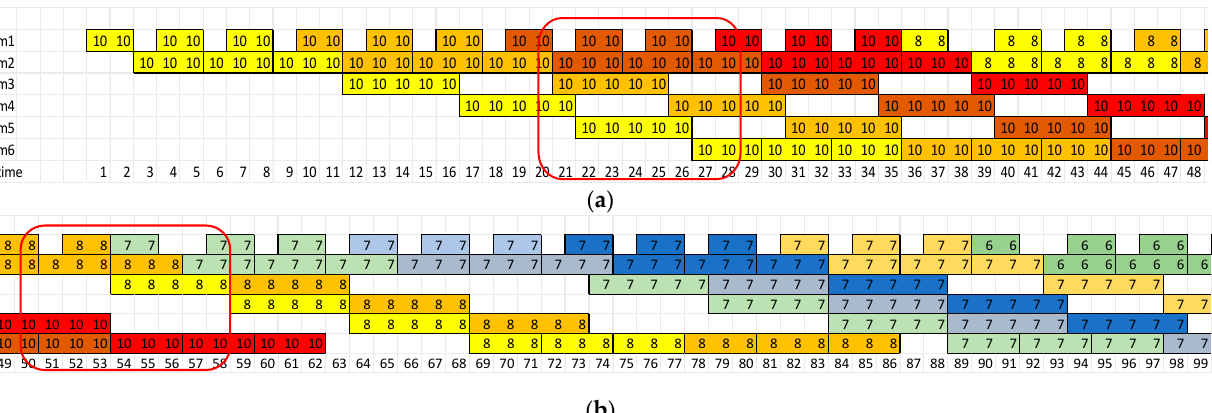
Figure 4. Gantt chart of the hybrid flow shop with a production batch and a transport batch (where m 1– m 6 —machine number; 1–99 time unit [mins]; 10,8,7,6—order number). ( a ) parallel washing of elements in chambers m 3 , m 4 and m 5 , ( b ) processing on machine m 6 after a fully completed washing cycle